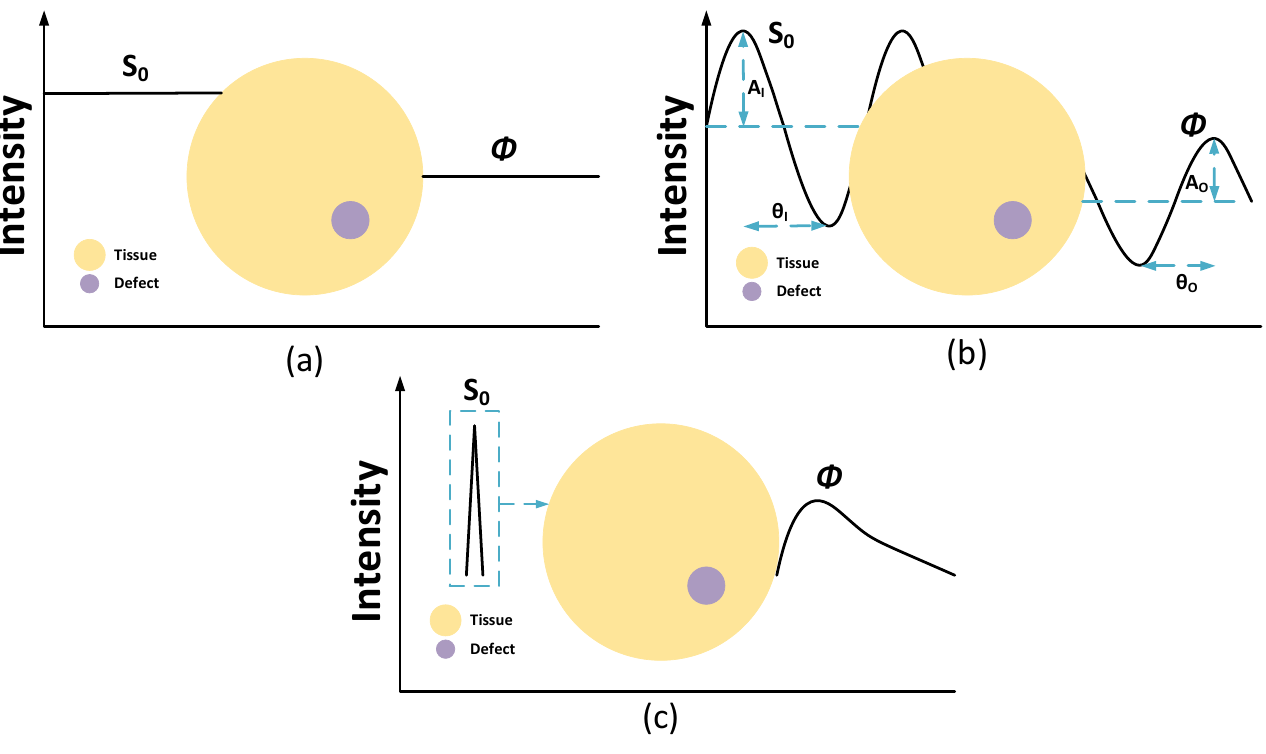
Figure 2. NIR-DOT measurement with ( a ) CW, ( b ) FD, and ( c ) TD. The yellow circle is tissue and the magenta circle is a defect.